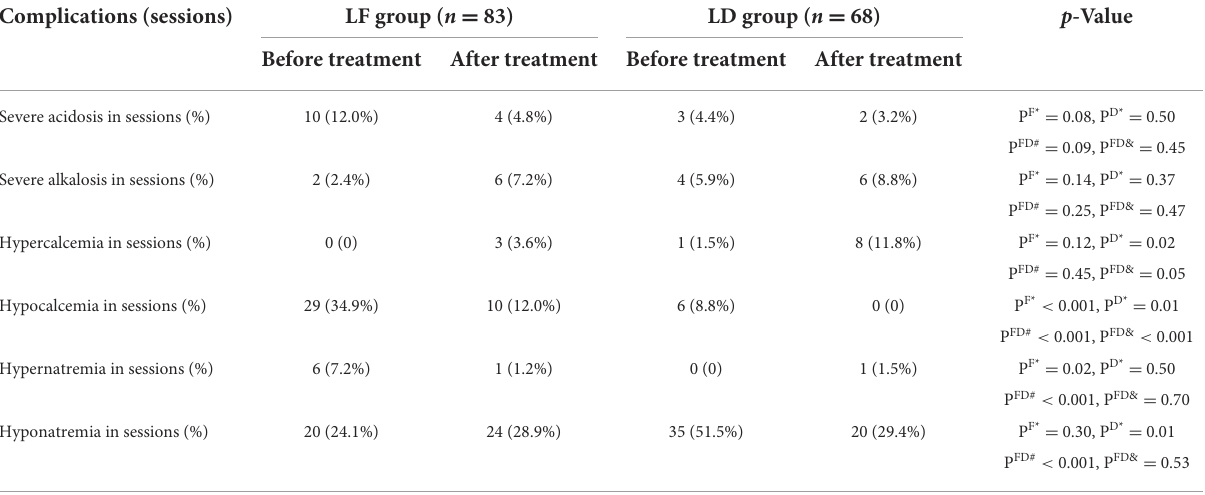
TABLE 2 Comparison of complications in the intracellular environment between the LF group and LD group.